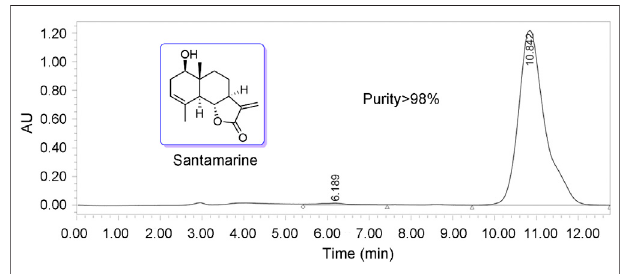
FIGURE 1 | Structure of santamarine and analysis of purity (purity > 98%).